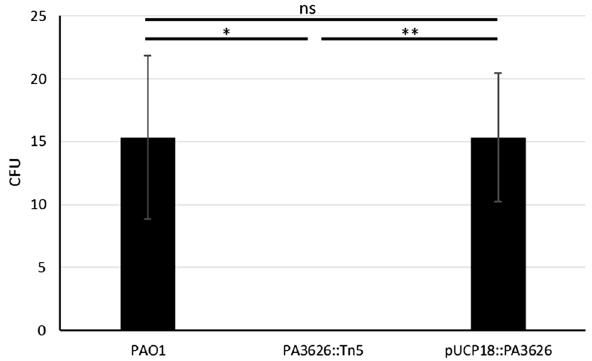
Figure 5. Complementation of PA3626 shows rescue of the phoenix phenotype. Phoenix colony counts were obtained for wild-type P. aeruginosa PAO1, the PA3626 transposon mutant, and the PA3626 complementation strain. After complementation of the transposon mutant, phoenix colony counts returned to wild-type levels, further confirming the importance of the tRNA pseudouridine synthase D in the emergence of phoenix colonies. *p < 0.05, **p < 0.01, n =